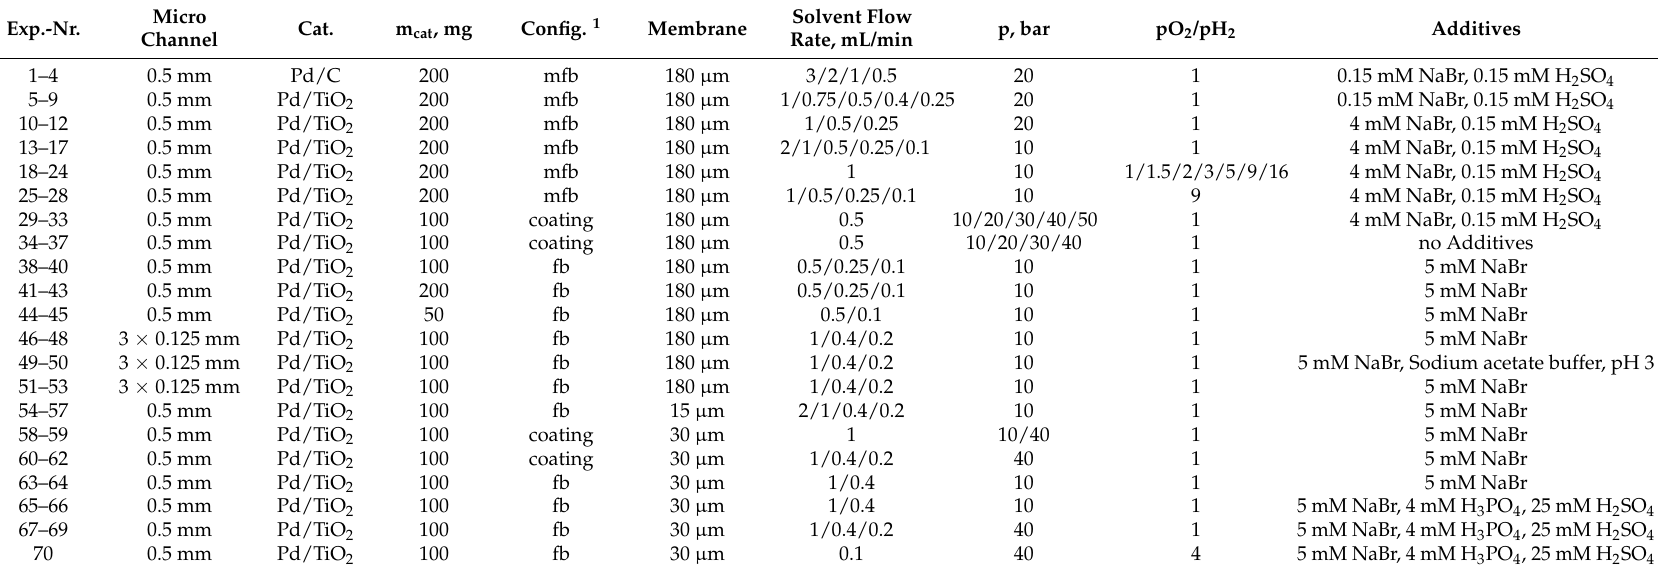
Table 1. Reaction conditions of the experiments performed in this